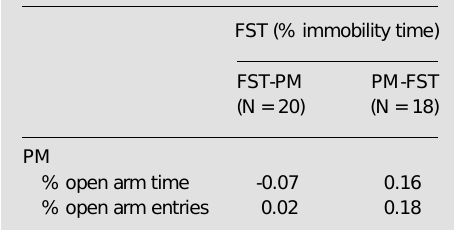
Table 1 - Pearson’s correlation between mouse behavior in the elevated plus-maze (PM) and forced swimming test